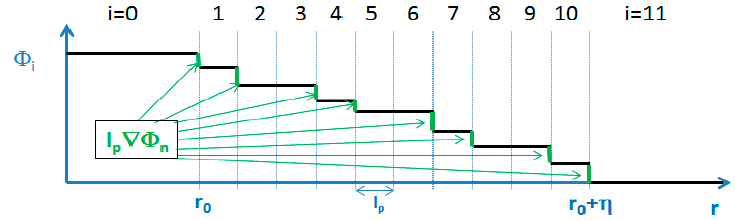
Figure 6. The  (cid:3041)(cid:2879)(cid:2869) −  (cid:3041) values of the Temkin model visualized as contrast i.e., (cid:1864)  (cid:3045)(cid:3041) (cid:2004) (in